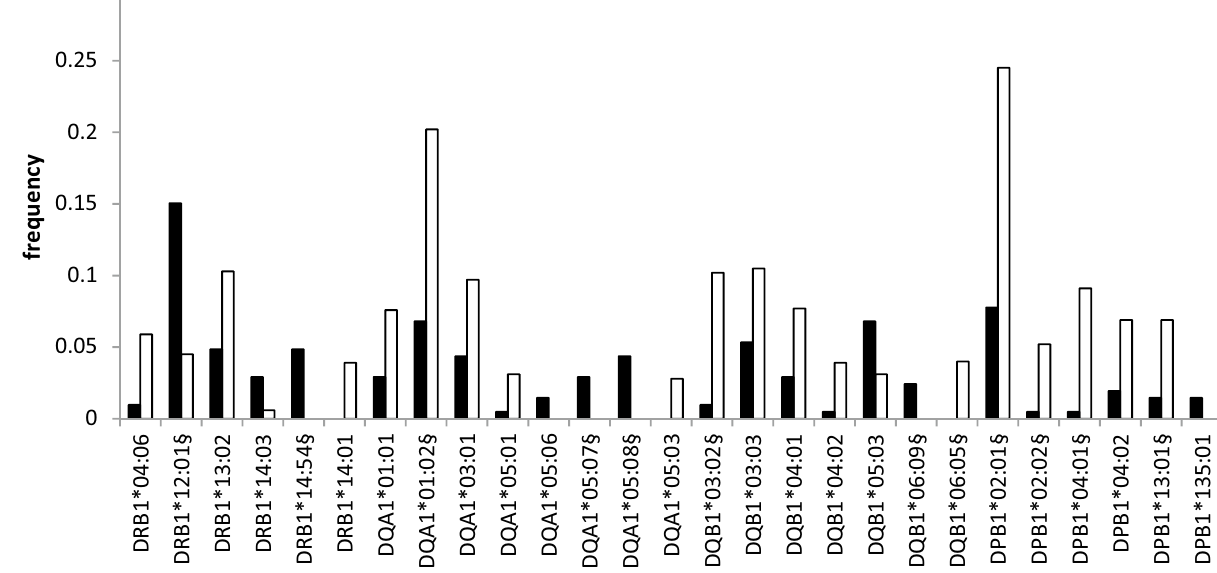
Figure 2. HLA Frequencies of HLA class II alleles associated with sarcoidosis in Koreans. Patients—black columns, Control population—white columns. § Significant p corr .